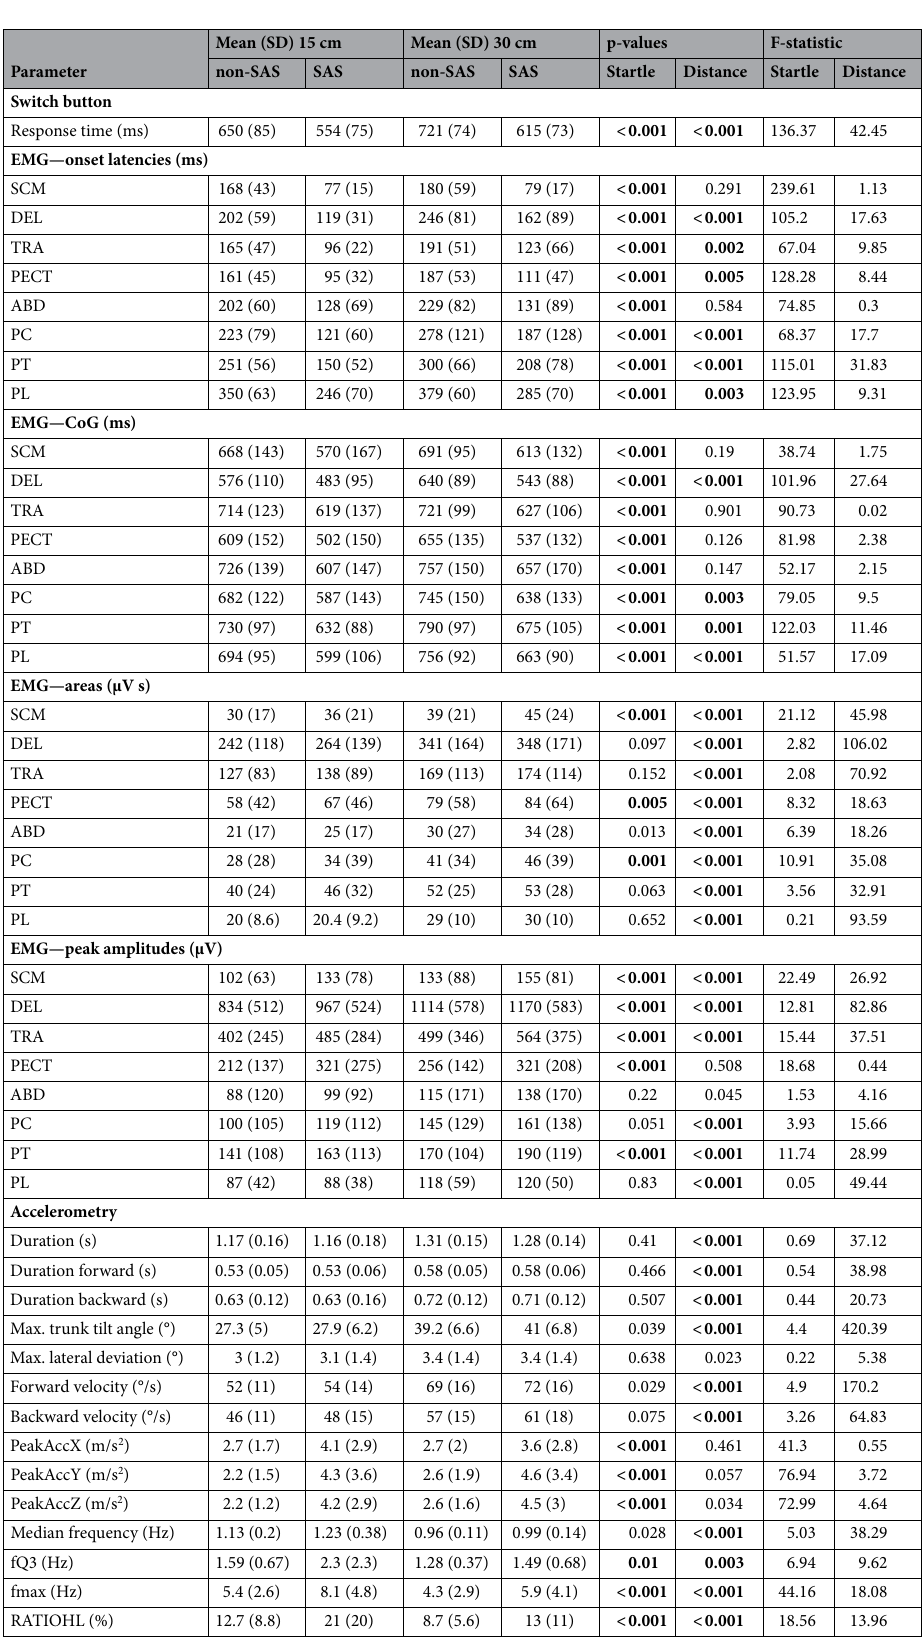
Table 1. Outcome measures in non-SAS and SAS trials, both at 15 cm and 30 cm. The first four columns show the Mean (SD) for each condition, and the last four columns show the results of the statistical analysis, using two- way repeated measures ANOVA with Startle effect and Distance as factors. p-values < 0.01 are highlighted in